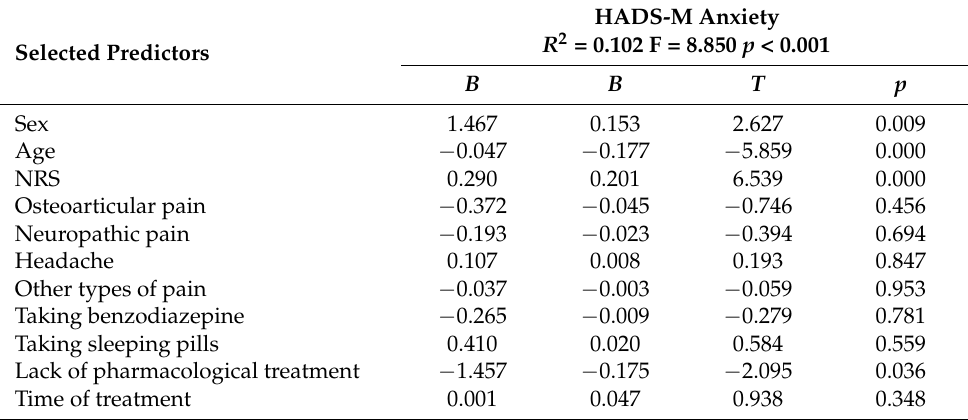
Table 3. Regression Analysis for the HADS-M: Anxiety.